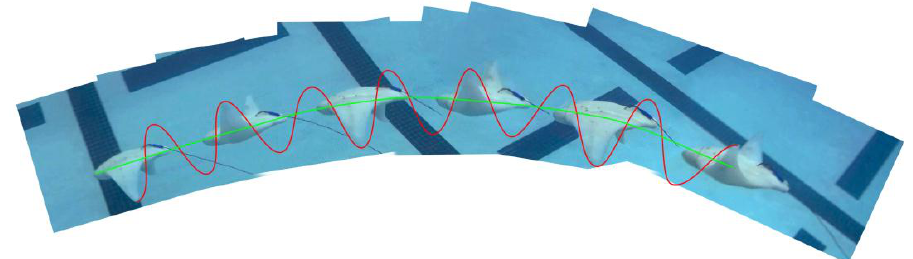
Figure 20. Sequential images of MantaBot swimming in a pool from right to left. The red line traces the pathway of the fin tip in a sinusoidal motion and the green line traces the trajectory of the MantaBot.